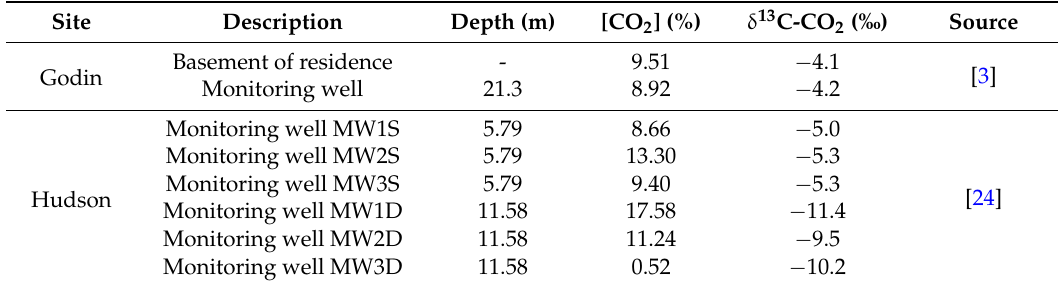
Table 4. Isotope ratios of the underlying CO 2